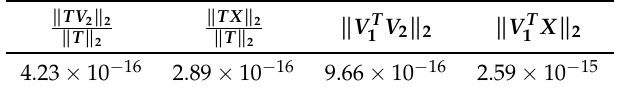
V 2 and norm of V T X , for Example 1 1